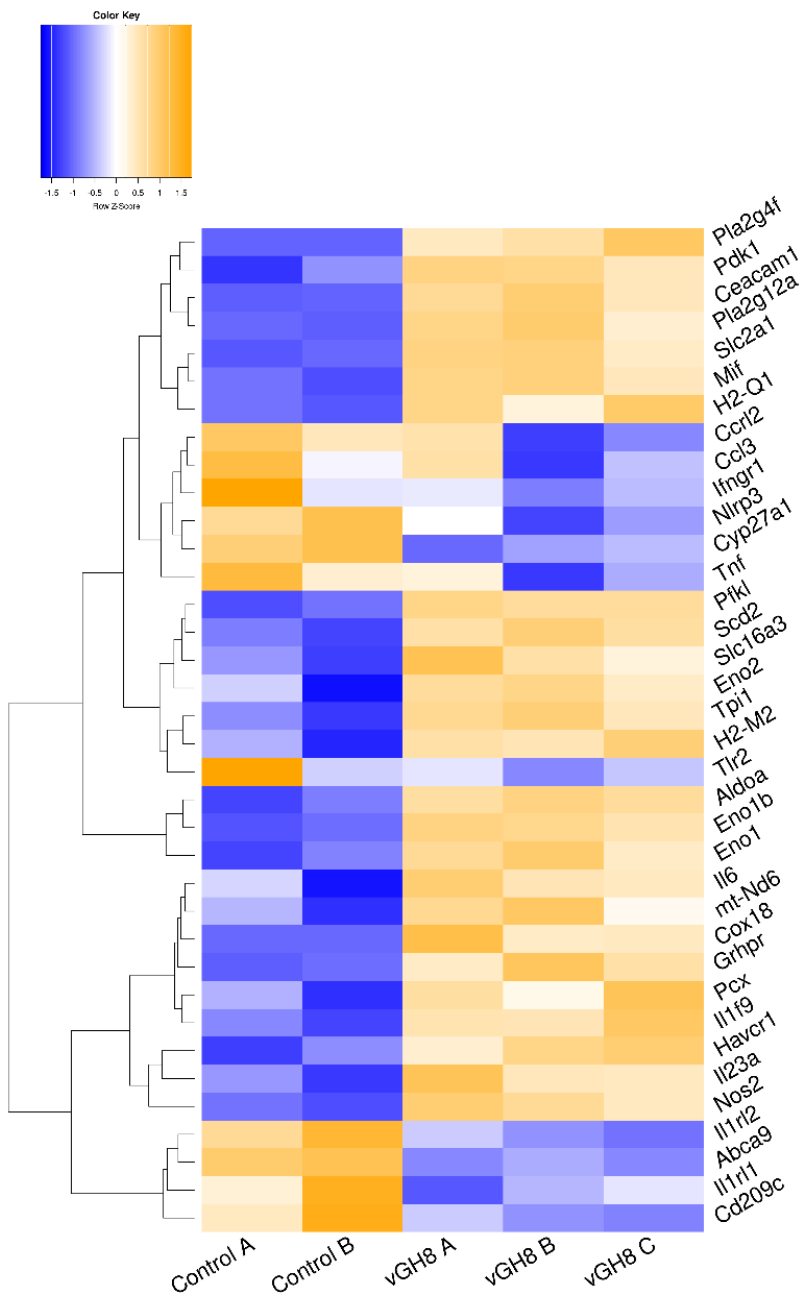
Figure 4. Unsupervised hierarchical clustering based on expression of metabolism-related DEGs between vGH8 versus Control BMDCs.